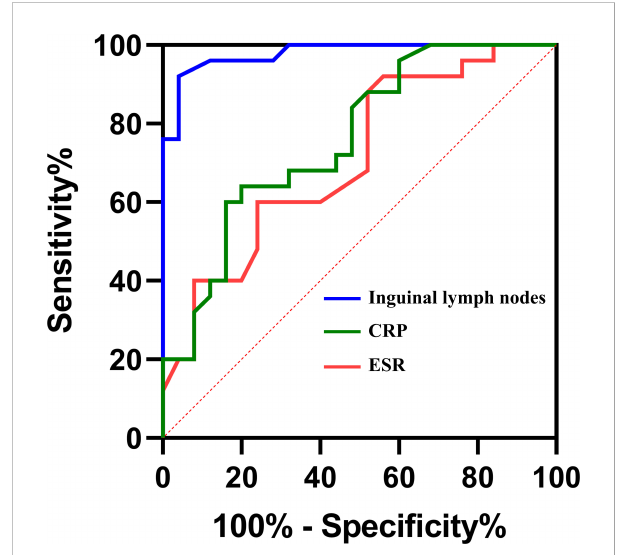
FIGURE 4 Receiver Operating Characteristic curves (ROCs) and area under curves (AUC) of the three tests in diagnosing